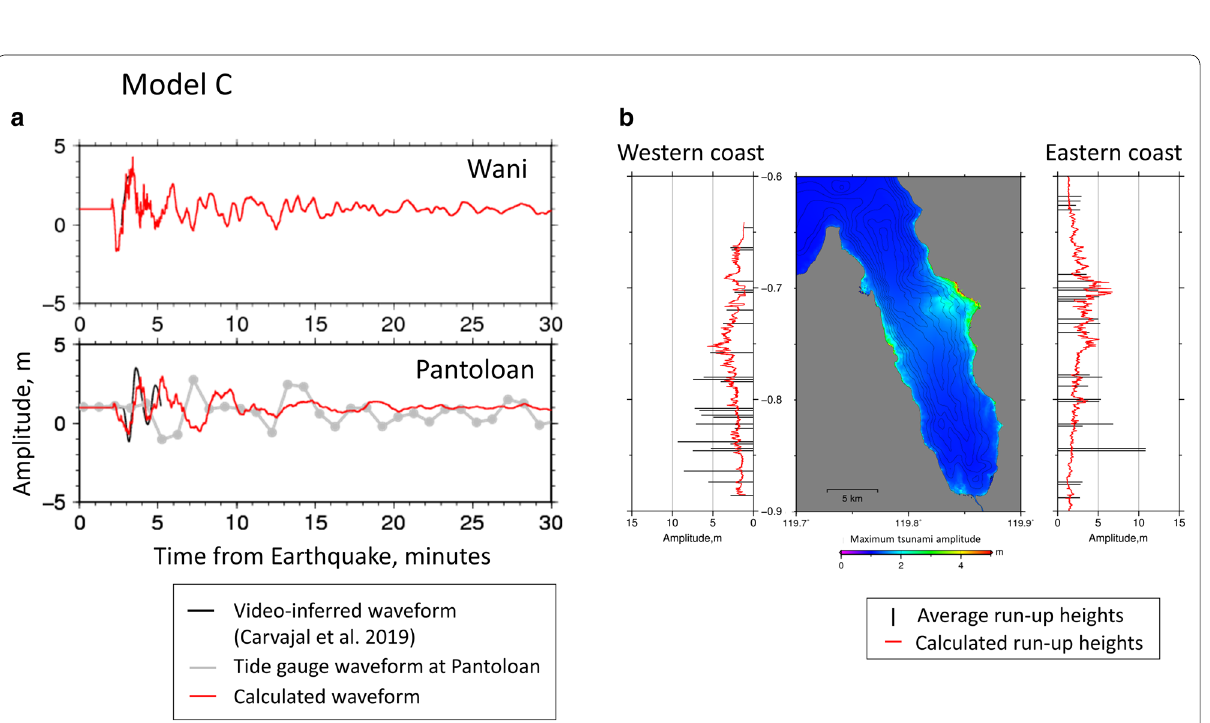
Reported latitudes and longitudes are for the centers of the landslide masses